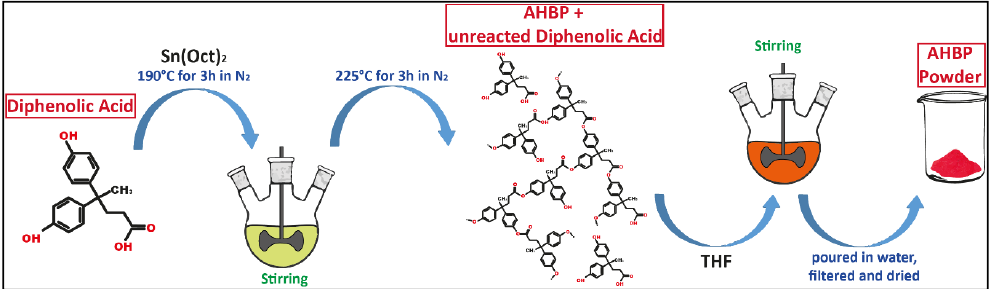
Figure 2. The synthesis procedure of aromatic hyperbranched polyester (AHBP).